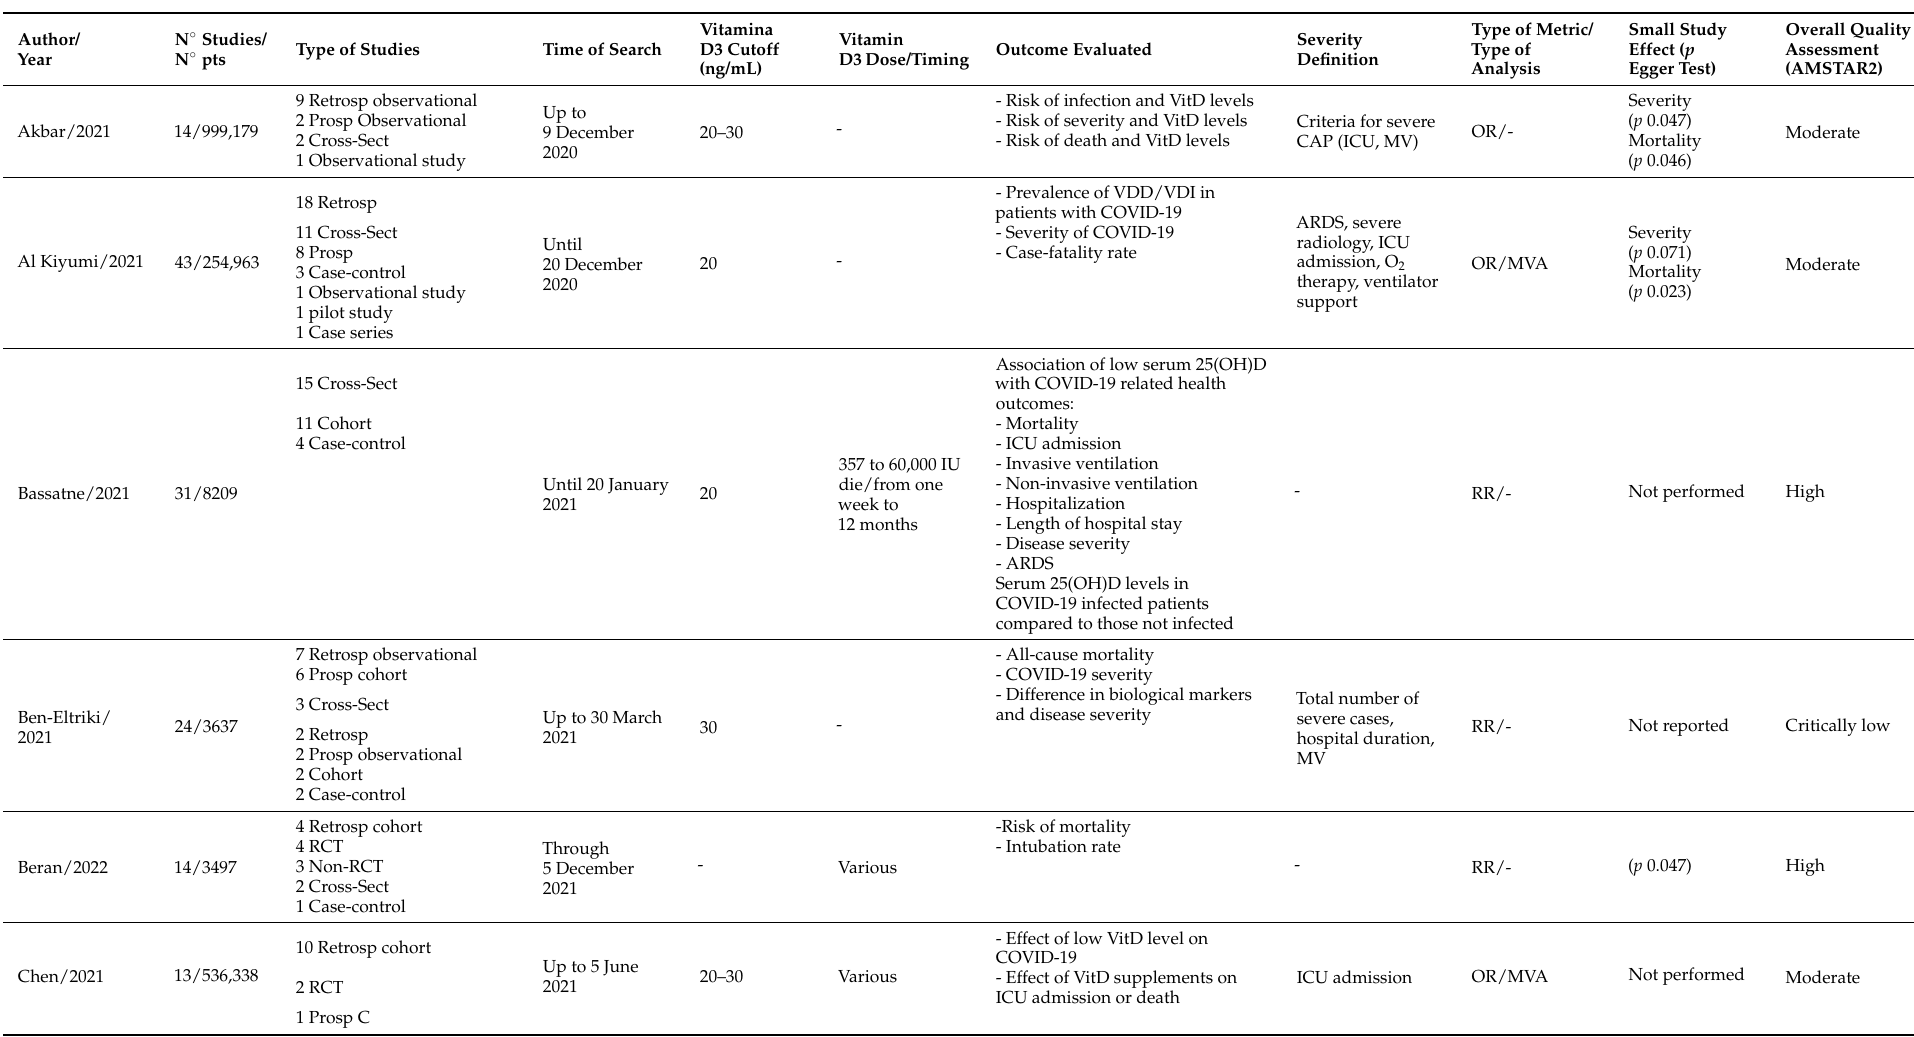
Table 1. Characteristics of the included